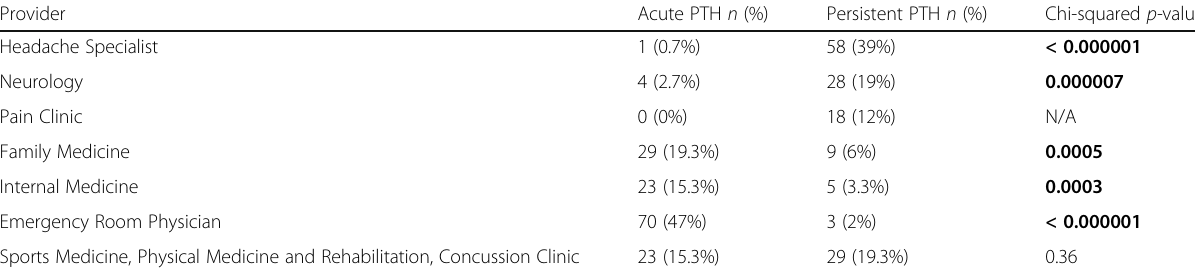
Table 3 Provider who diagnosed acute and persistent PTH